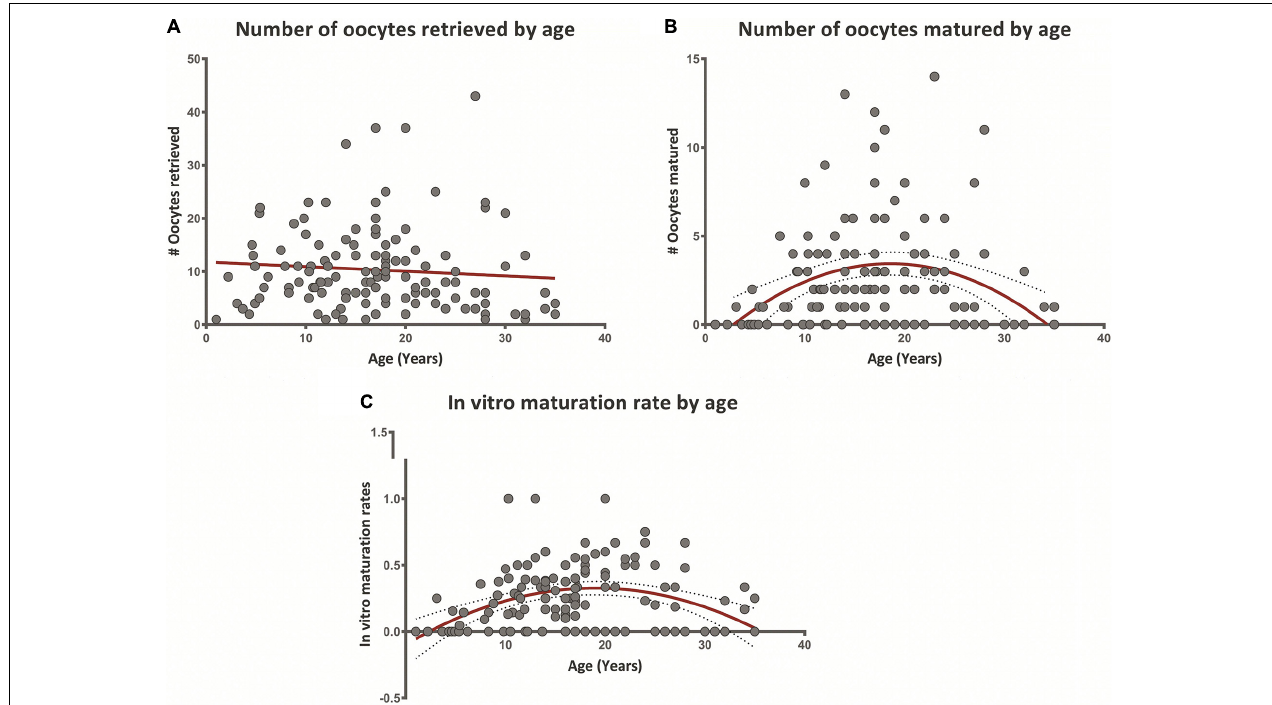
FIGURE 2 | (A–C) Oocyte retrieval following ovarian tissue cryopreservation and in vitro maturation outcomes according to patient age (1–35 years). (A) Number of oocytes retrieved following ovarian tissue cryopreservation according to patient age. Linear regression trend is observed in red. (B) Number of oocytes matured by in vitro maturation according to patient age. Quadric fit line presented in red, with confidence interval of 95% (dotted lines). (C) Average rate of mature oocytes/total oocytes retrieved ( in vitro maturation rate) per patient according to age. Quadric fit line presented in red, with confidence interval of 95% (dotted